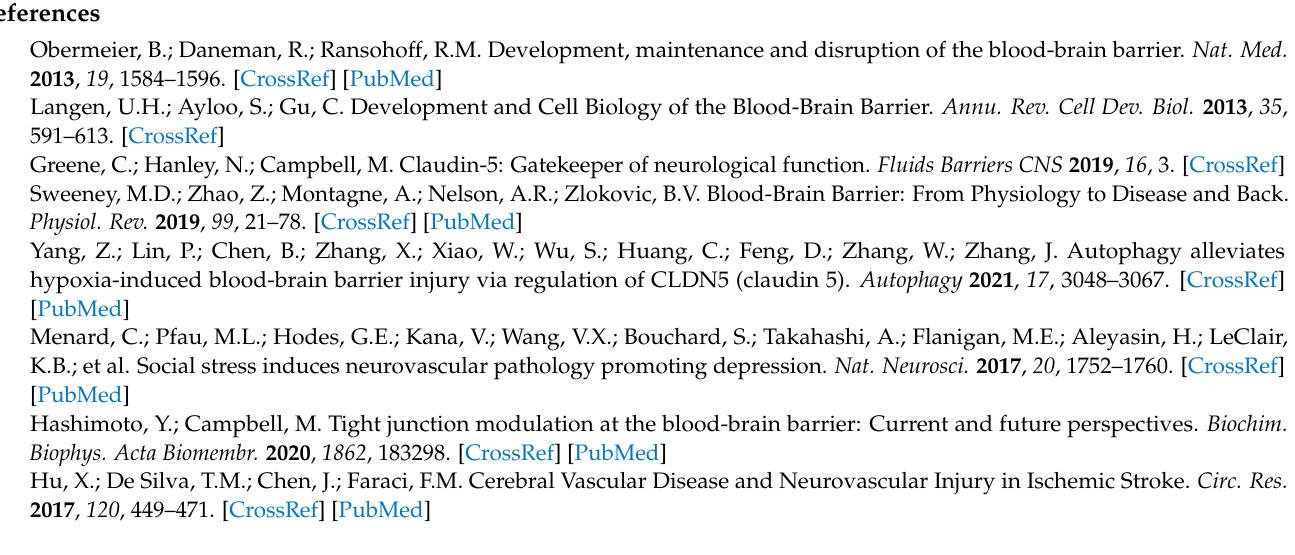
borneol; Figure S2: The local cerebral blood flow of MCAO mice; Figure S3: Cytotoxicity of muscone and (+)-borneol on bEnd.3 cells; Figure S4: Small interfering RNA (siRNA) screening; Figure